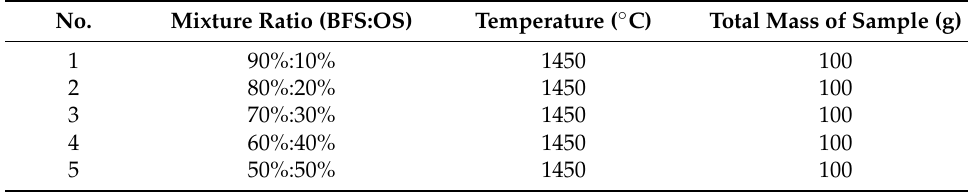
Table 4. Experimental plan for the pyrolysis of OS by